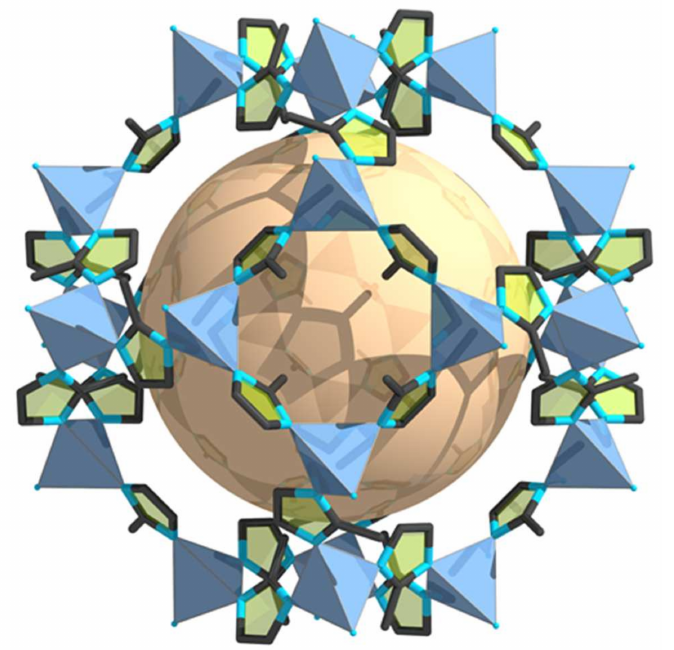
Figure 13. Crystal structure of ZIF-8 with the underlying sod topology, where blue tetrahedra indicate the ZnN 4 SBUs. (Blue: nitrogen, and black: